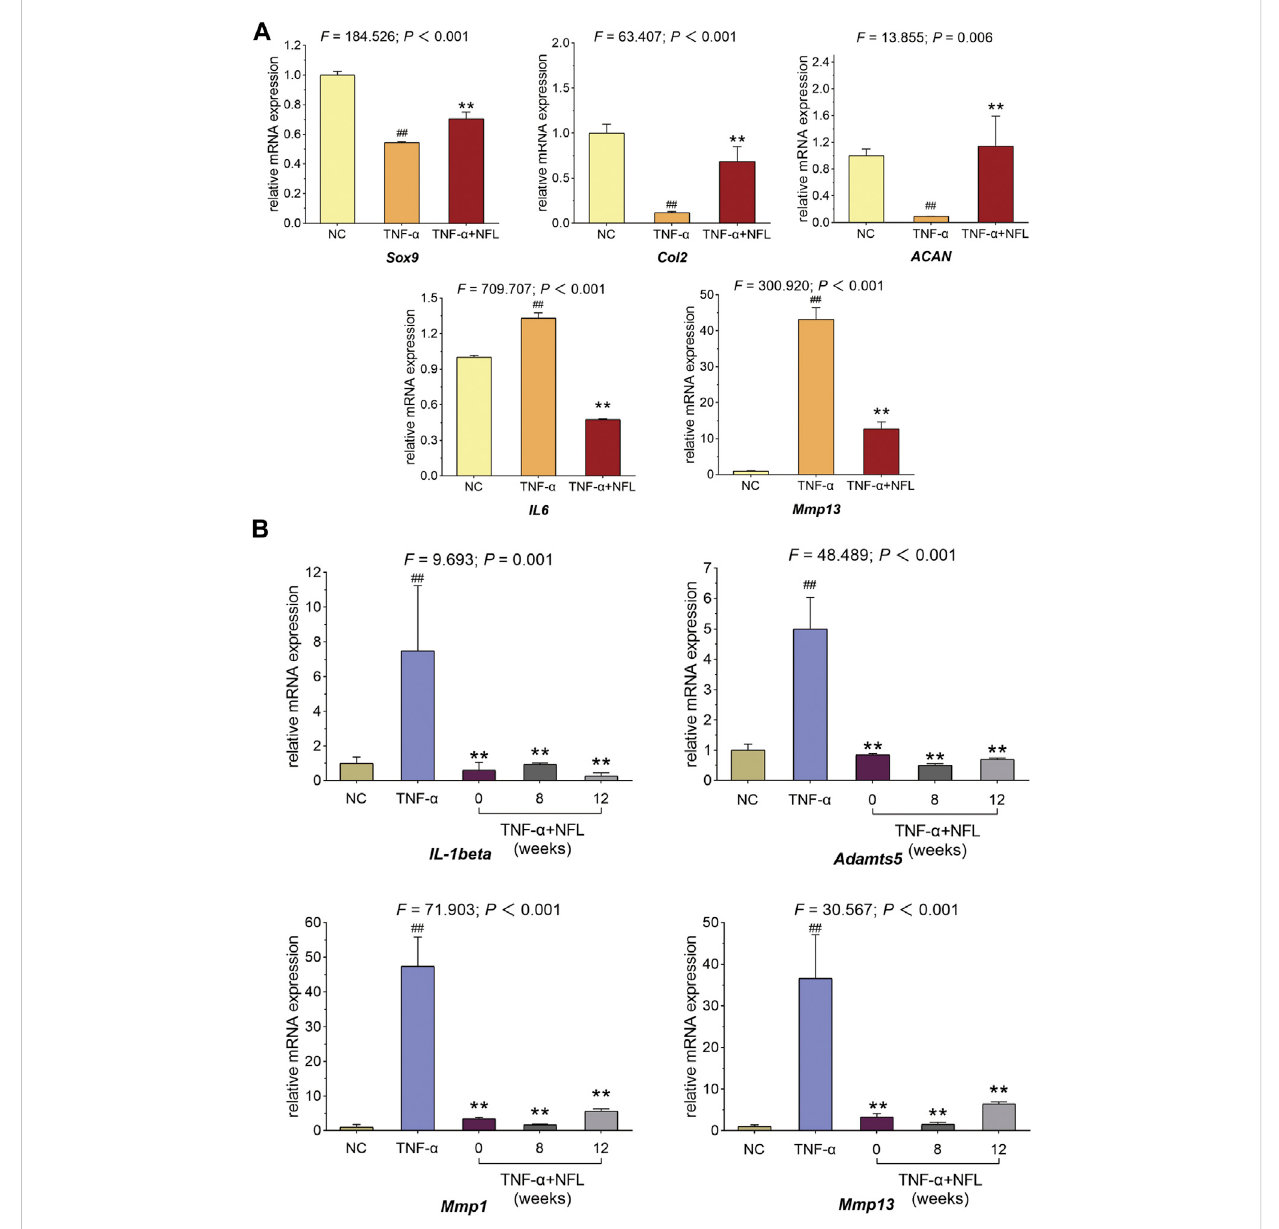
FIGURE 4 qPCR assay on chondrocytes with NFL and sNFL treatments. (A) Relative mRNA expressions of selected genes in chondrocytes with NFL treatment. (B) Relative mRNA expressions of selected genes in chondrocytes with NFL and sNFL treatments. Values are shown as mean ± SD. ## p < 0.01 vs . NC group; ** p < 0.01 vs . TNF- α